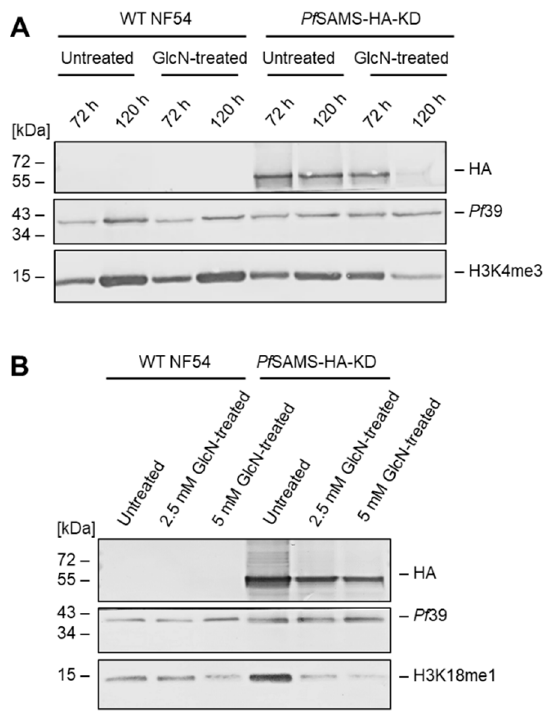
Figure 3. Effect of Pf SAMS deficiency on histone H3 methylation in the asexual blood stages. Lysates of untreated and GlcN-treated asexual blood-stage cultures in ( A ), 72 h and 120 h, using 5 mM GlcN; in ( B ), 72 h, using 2.5 or 5 mM GlcN) of the Pf SAMS-HA-KD line and WT NF54 were immunoblotted with rat anti-HA antibodies to detect Pf SAMS-HA (~50 kDa). Histone H3 methylation was detected by immunoblotting with rabbit antibodies directed against H3K4me3 (15 kDa) ( A ) and H3K18me1 (15 kDa) ( B ). Rabbit antisera directed against Pf 39 (39 kDa) was used as loading and viability control. The results ( A , B ) are each representative of two independent experiments.